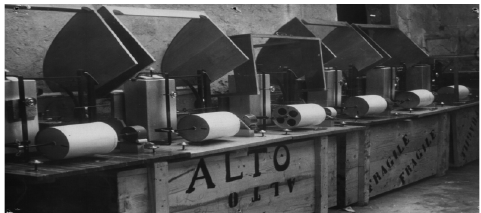
Fig. 1. «RABEN» (RAffaele BENdandi) micro seis- mographs, lined up at the Observatory and ready for shipping.